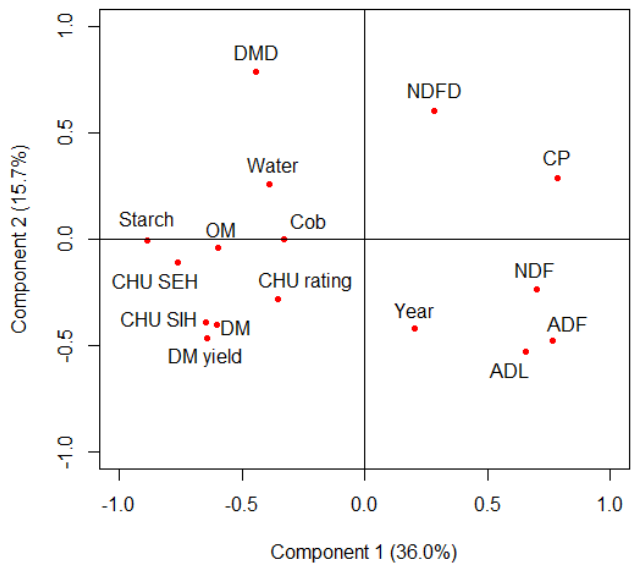
Figure 1. Component pattern plot obtained by principal component analysis describing the relationship among corn silage quality parameters and yield as well as agronomic practices (ADL, acid detergent lignin (% DM); ADF, acid detergent fiber (% DM); CHU rating, corn heat unit rating; CHU SHE, corn heat unit from seeding to harvesting; CHU SIH, corn heat unit from silking to harvesting; Cob, cob percentage (% DM); CP, crude protein (% DM); DM, dry matter (%); DMD, 48 hours dry matter digestibility (% DM); DM yield (T ha − 1 ); OM, organic matter (% DM); NDF, neutral detergent fiber (% DM); NDFD, 48 hours neutral detergent fiber digestibility (% NDF); Starch (% DM); Water, total water supply